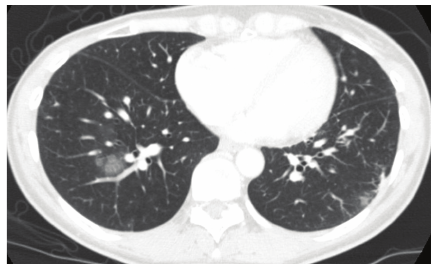
Figure 1: Computer tomography scans of the chest revealed ground glassopacitiesaroundthebronchovascularbundlesinthelowerlobe of the right lung.